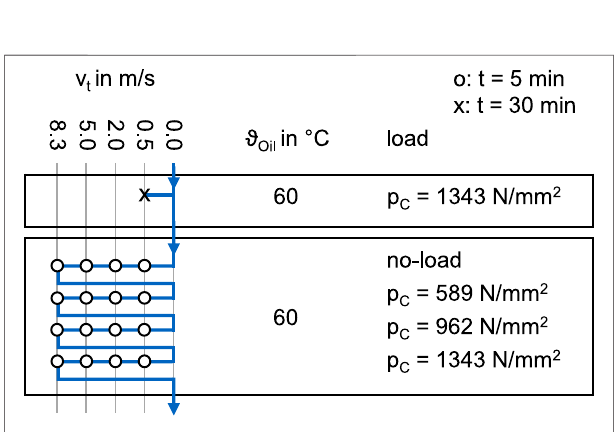
FIGURE 5 | Experimental test order at the gear ef fi ciency test rig.